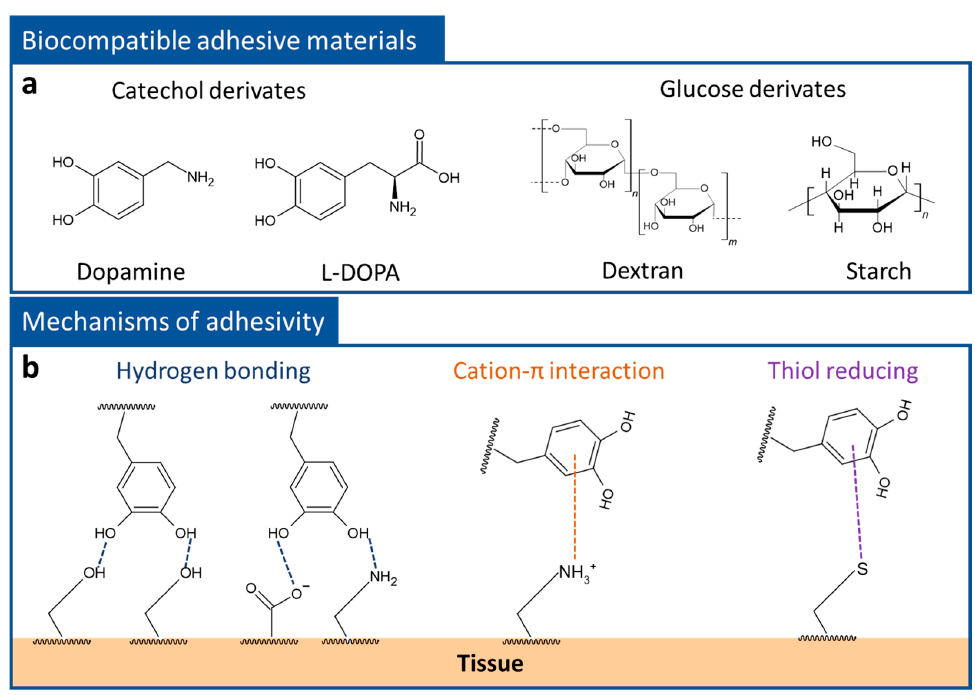
Figure 3. ( a ) Biocompatible adhesive materials are classified into catechol derivates (dopamine, and 3,4-dihydroxy-L-phenylalanine (L-DOPA)) and glucose derivates (dextran and starch). ( b ) Schematic description of the tissue adhesivity of catechol derivates: hydrogen bonding, cation-pi interaction, and thiol reduction.